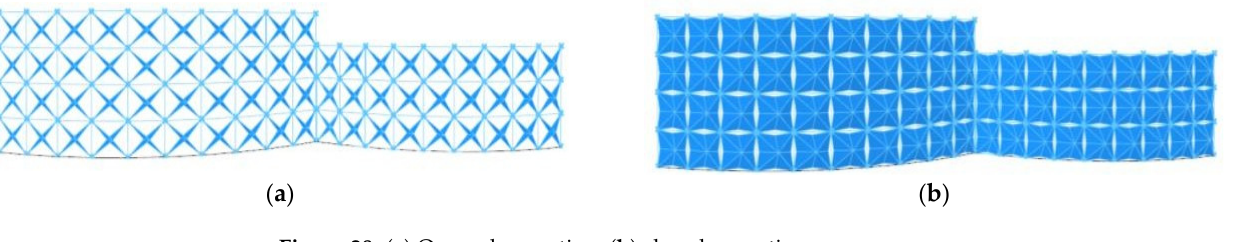
Figure 28. ( a ) Opened operation, ( b ) closed operation.